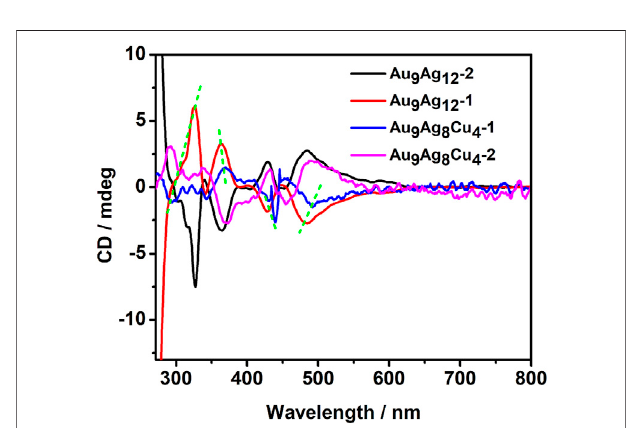
FIGURE 4 | The circular dichroism (CD) spectra of the enantiomer in (A) [Au 9 Ag 12 (SAdm) 4 (Dppm) 6 Cl 6 ](SbF 6 ) 3 and (B) [Au 9 Ag 8 Cu 4 (SAdm) 4 (Dppm) 6 Cl 6 ](SbF 6 ) 3 nanoclusters.